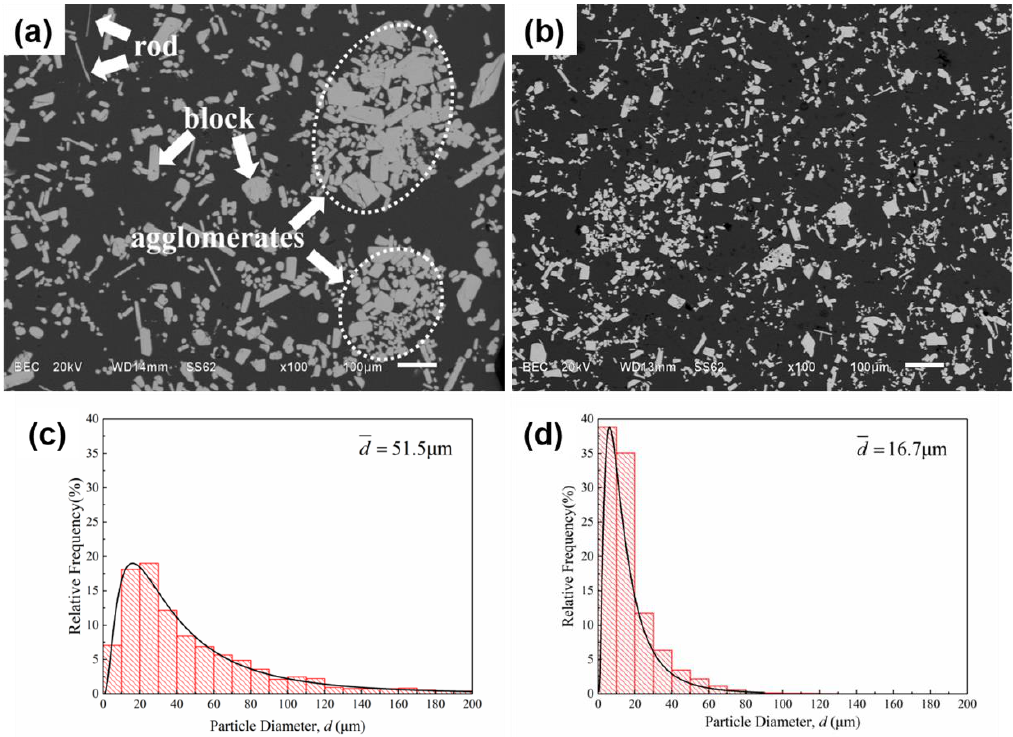
Figure 4. SEM micrographs and size distribution of Al3Zr particles in the Al-0.2%Zr alloy solidified at 0.4 °C/s ( a , c ) without IC-AEMS and ( b , d ) with IC-AEMS.